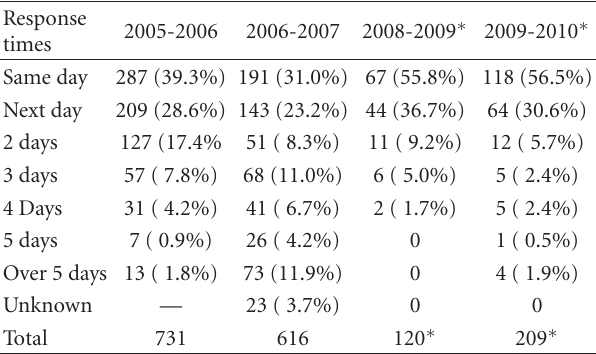
Table 1: Response time for seeing patients referred to the LOAP. ∗ Data refers to 3-month period only. Please note that for the period 2008-2009 and 2009-2010 only 3-month audits were completed on the LOAP response